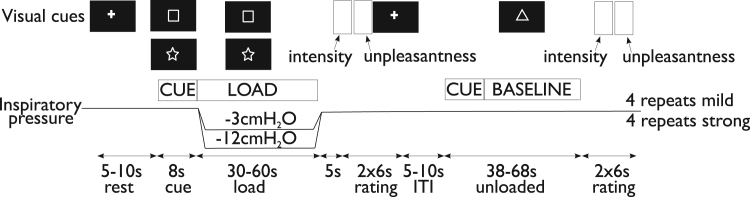
Schematic illustration of experimental session and aversive conditioning paradigm. Prior to the application of each inspiratory load, the fixation cross on the screen changed to one of three shapes, a triangle, a square and a star to signal the imminent application of a stimulus (mild inspiratory load, strong inspiratory load) for eight seconds (anticipation period). The shape remained on the screen during the application of the stimulus (stimulus period) for 30–60 s and changed back to the fixation cross when the stimulus ceased. The shapes were counterbalanced across participants. Each inspiratory load was followed by an unloaded period of between 30 and 60 s that was indicated by a third visual cue. The use of relatively long breathlessness stimuli was chosen to maximize the emotional responses associated with anticipation of breathlessness. Participants rated their respiratory intensity and unpleasantness after each stimulus. Visual stimuli were generated and presented in white on a black background using the Cogent toolbox (www.vislab.ucl.ac.uk/Cogent/) for MatLab (MathWorks Inc., Natick, MA, USA).